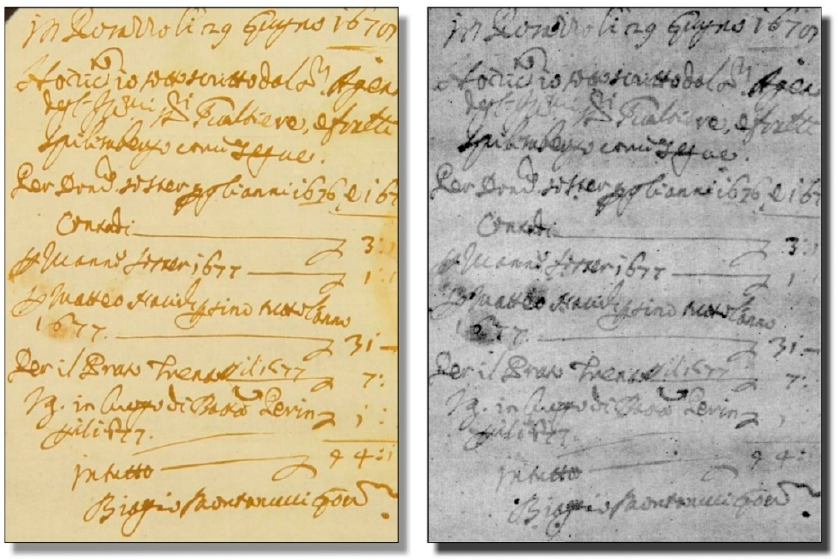
Figure 23. A manuscript revealed by radiography (right), compared to the corresponding visible-light picture [29–31].